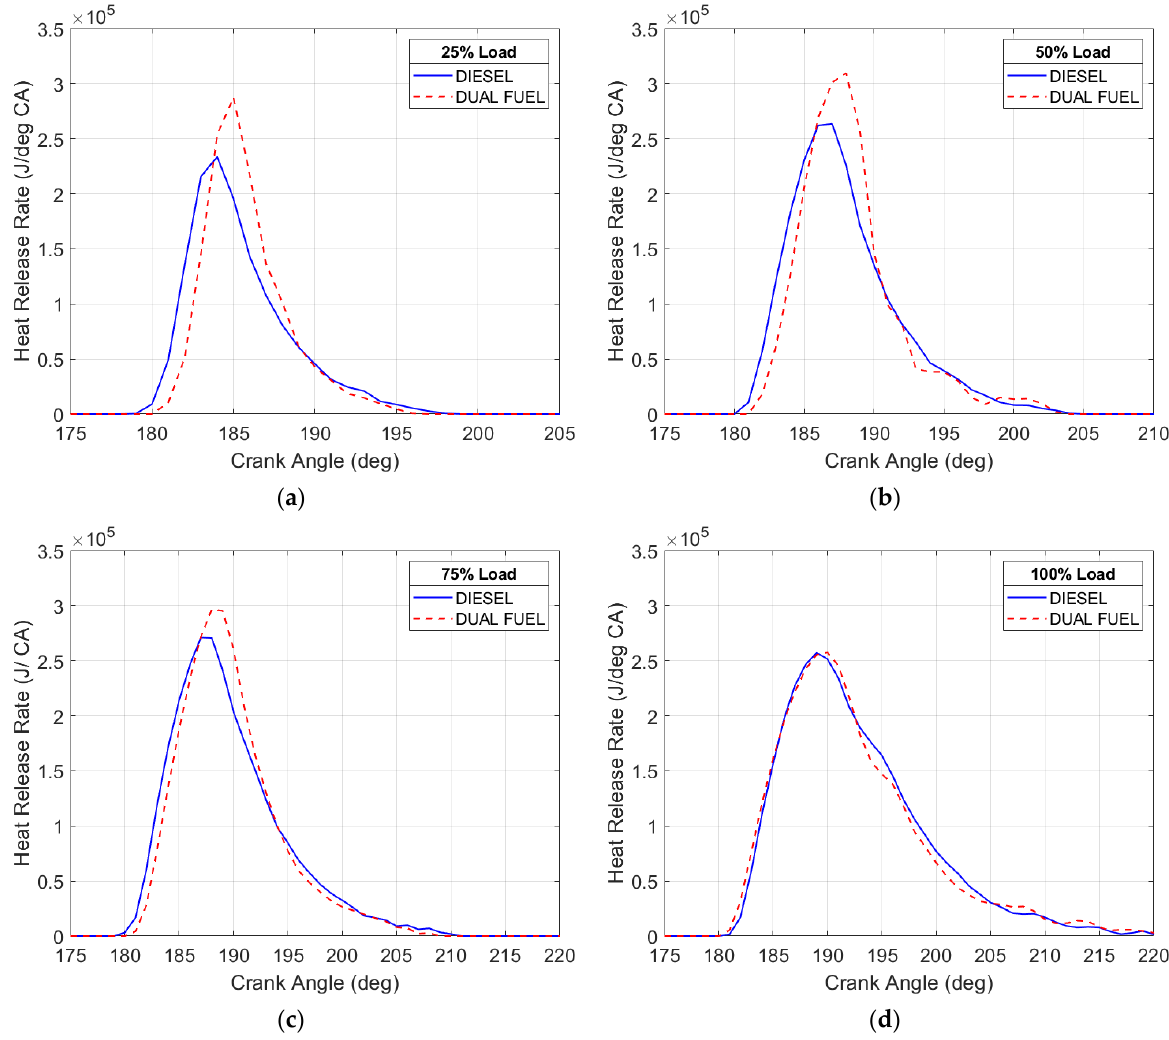
Figure 9. ( a ) Net mean heat release rate at 25% load, diesel and DF modes; ( b ) Net mean heat release rate at 50% load, diesel and DF modes; ( c ) Net mean heat release rate at 75% load, diesel and DF modes; ( d ) Net mean heat release rate at 100% load, diesel and DF modes. modes; ( d ) Net mean heat release rate at 100% load, diesel and DF